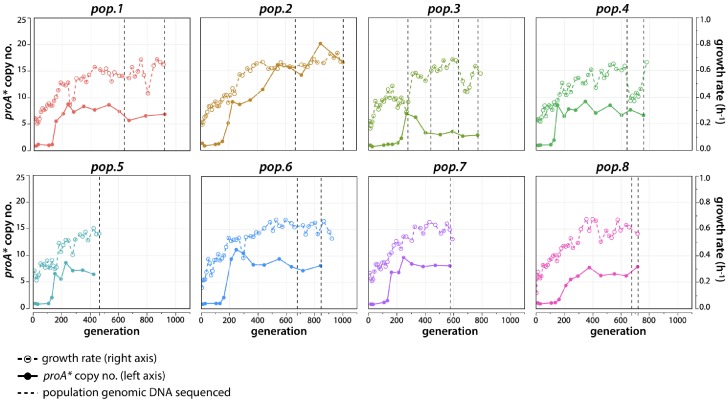
Growth rate (right axis, dotted lines) and proA* copy number (left axis, solid lines) for each evolved population.Vertical dotted lines indicate when population genomic DNA was sequenced.